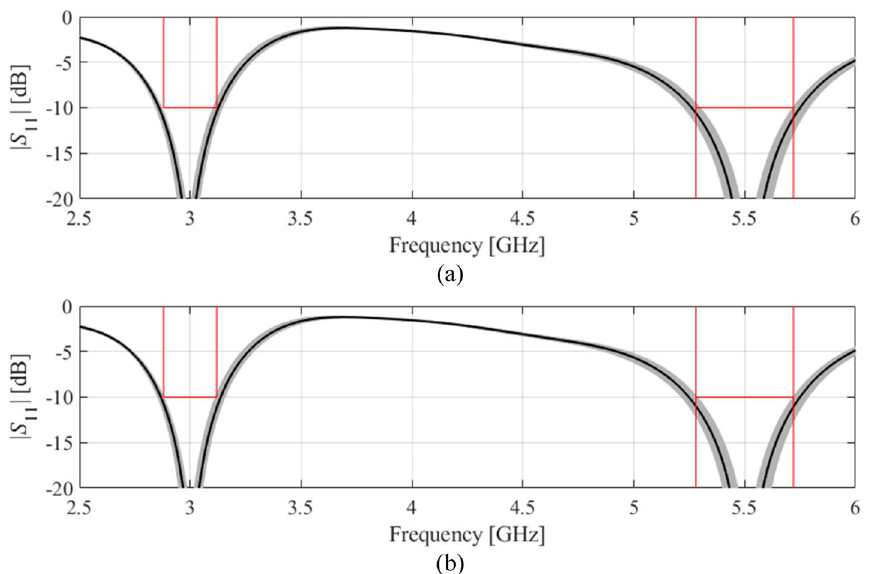
Figure 5. Visualization of EM-driven Monte Carlo simulation of Antenna II using 500 samples. Gray plots represent random observables, whereas the black plot is the antenna response at the center design (nominal for ( a ) and yield-optimized for ( b )). Target operating bandwidths and reflection level has been marked using vertical and horizonal lines, respectively: ( a ) nominal design, ( b ) robust